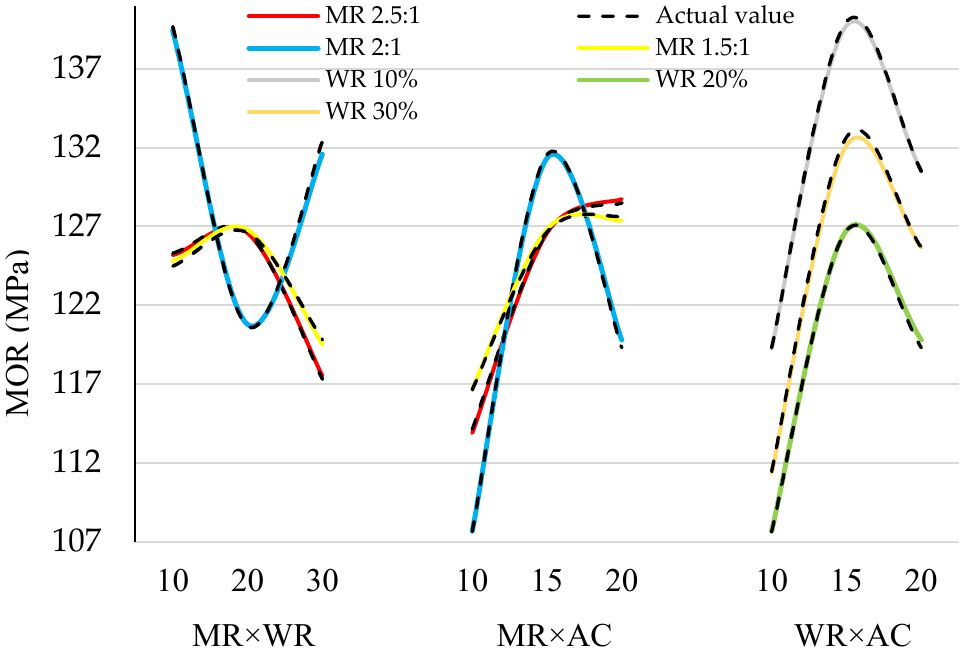
Figure 6. The comparison of the interactive real and estimated effects of ( left ) ANN MR × WR, ( center ) MR × AC, and ( right ) WR × AC on the bending strength.